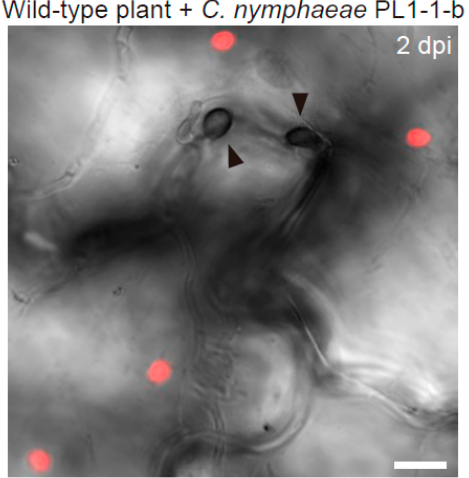
Figure 1. Arabidopsis epidermal chloroplast response (ECR) against nonadapted fungal pathogen Colletotrichum nymphaeae PL1-1-b. The epidermal surface of the pathogen-inoculated cotyledon of the wild-type plant was investigated at 2 days post-inoculation (dpi). The chloroplasts were visualized based on chlorophyll autofluorescence. The DIC image was captured by confocal microscopy. The arrowheads indicate melanized appressoria. Scale bar, 10 µm.